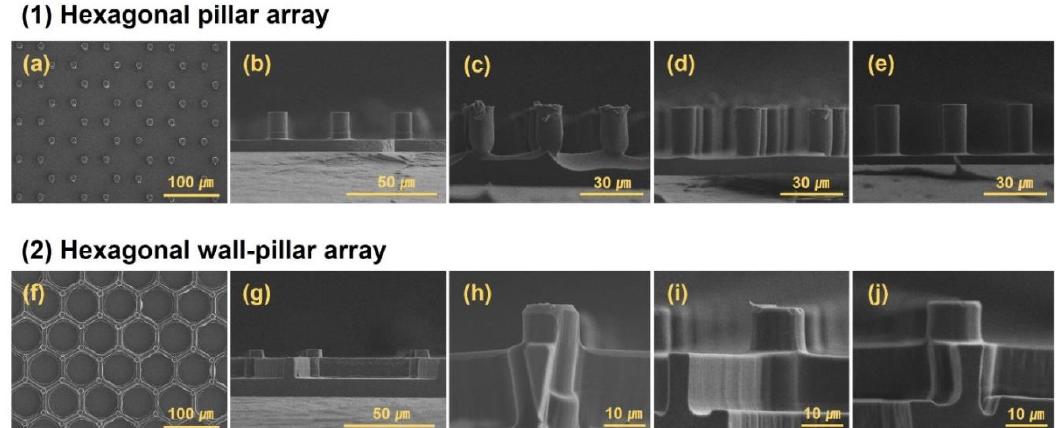
Figure 3. Micro-pattern deformation before and after tulip-shaped pattern imprinting process (variable: ultraviolet (UV) energy). ( a , b ) Hexagonal pillar array pattern morphology before experiments. ( c – e ) Hexagonal pillar array pattern morphology after experiments; UV irradiation energy: ( c ) 150 mJ, ( d ) 180 mJ, ( e ) 300 mJ. ( f , g ) Hexagonal wall-pillar array pattern morphology before experiments. ( h – j ) Hexagonal wall-pillar array pattern morphology after experiments; UV irradiation energy: ( h ) 150 mJ, ( i ) 180 mJ, ( j ) 300 mJ.